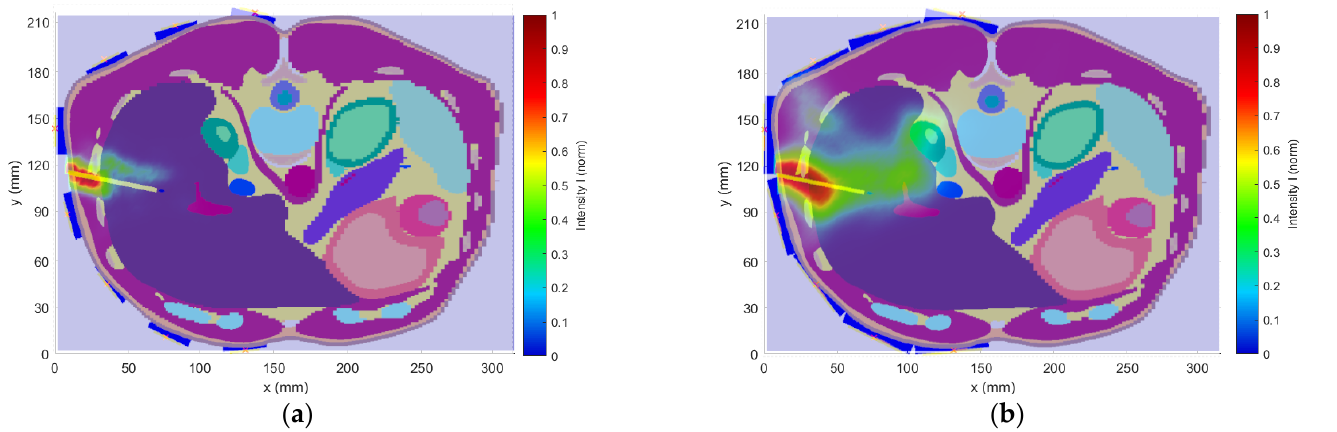
Figure 16. The antenna polarization study results: ( a ) Reconstruction for vertically placed antennas; ( b ) Reconstruction for horizontally placed antennas.